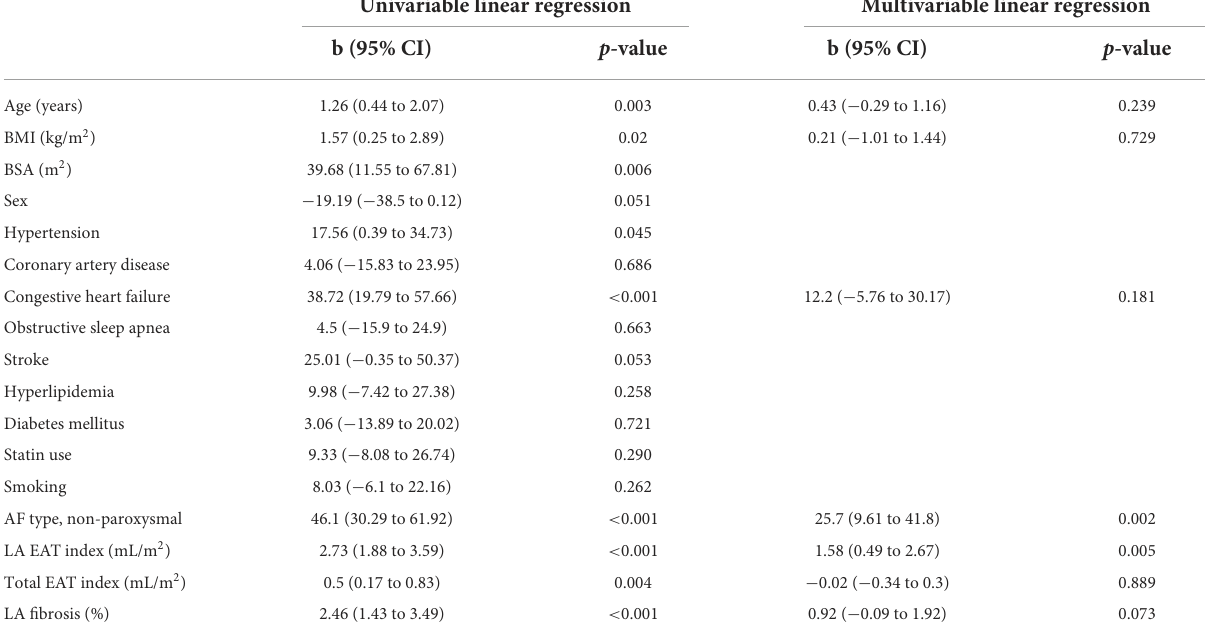
TABLE 2 Univariable and multivariable linear regression for the association between LA volume and baseline variables. Univariable linear regression Multivariable linear regression